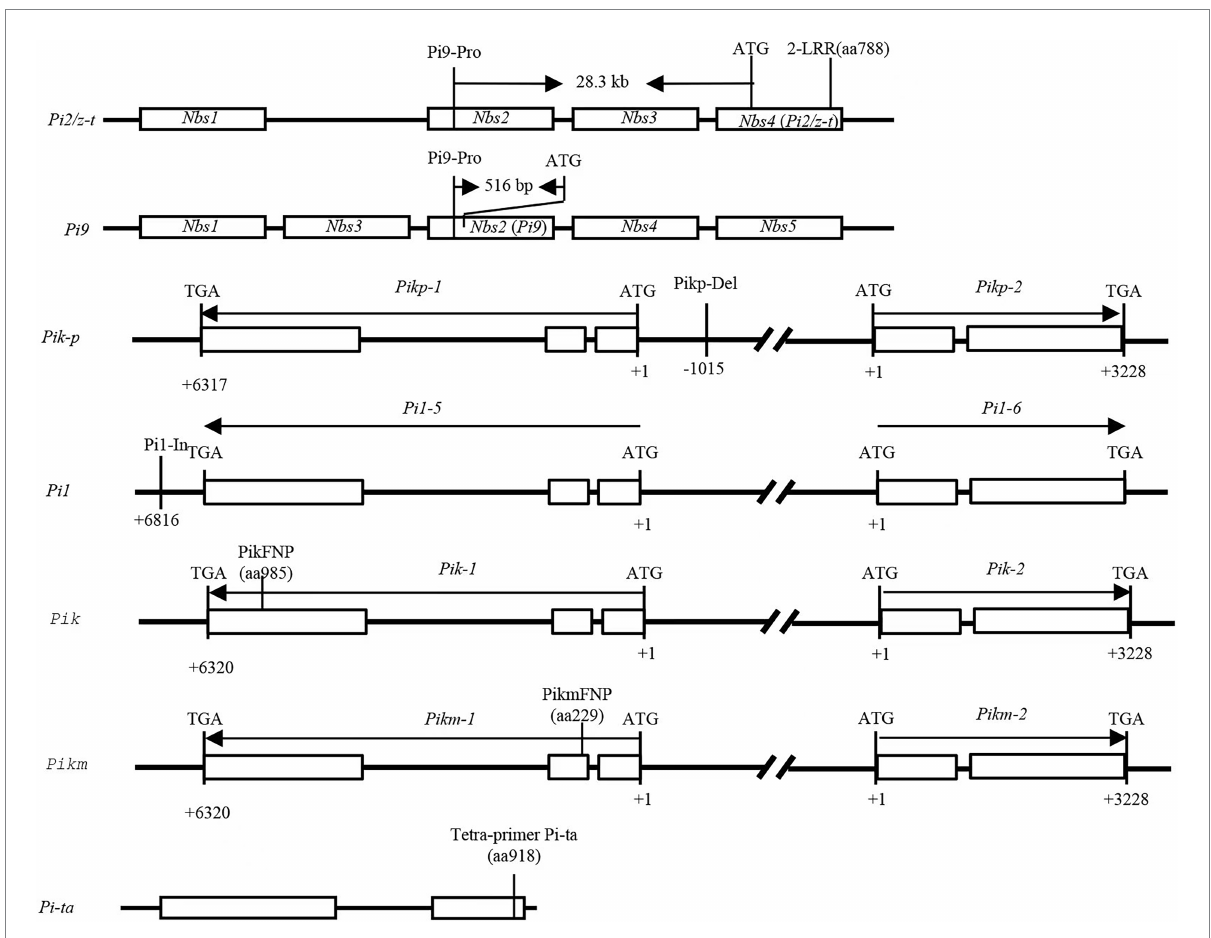
FIGURE 1 The physical maps of nine genes and their molecular markers in the study. The position of the nine molecular markers on the corresponding